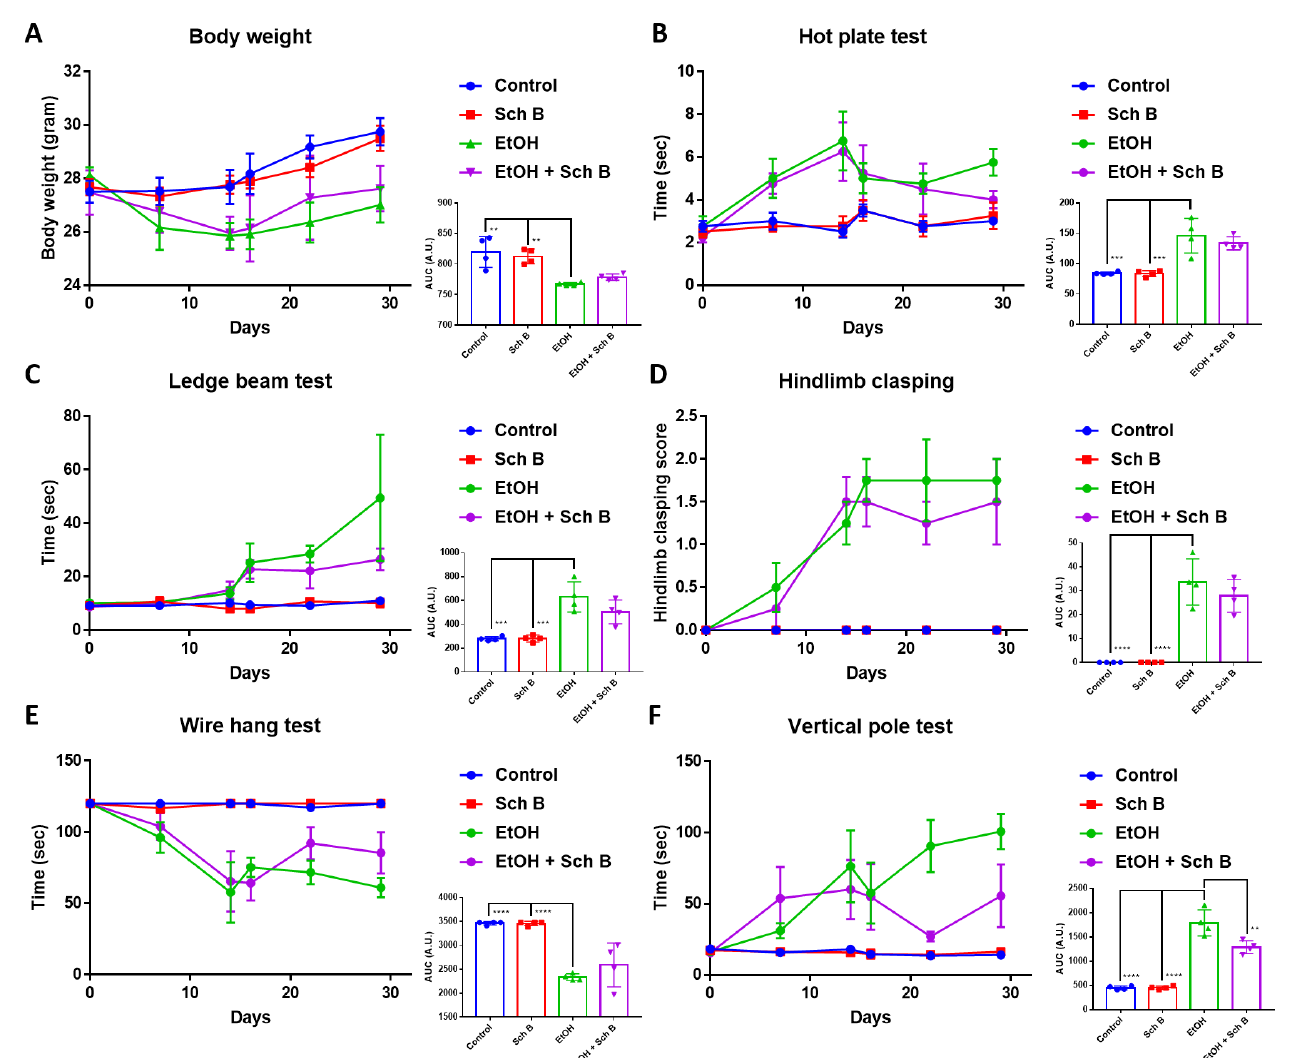
Figure 8. Schisandrin B repairs ethanol-induced neurofunctional defects. ( A ) Mouse body weight. Assessment of neurological functions in mice using the ( B ) hot plate, ( C ) ledge beam, ( D ) hindlimb clasping, ( E ) wire hang, and ( F ) vertical pole tests. n = 4 mice. Results are expressed as mean ± standard error mean (SEM), and area under the curve (AUC) values are expressed as mean ± SD. ** p < 0.01, *** p < 0.001, and **** p < 0.0001. Finally, Sch B treatment significantly reduced ethanol-induced neuron cell death (Figure 9A,B) and improved reduced CSF LDH levels (Figure 9C). BBB damage was also significantly repaired by Sch B, as suggested by the reduced CSF-to-serum albumin ratio compared with the ethanol-treated group (Figure